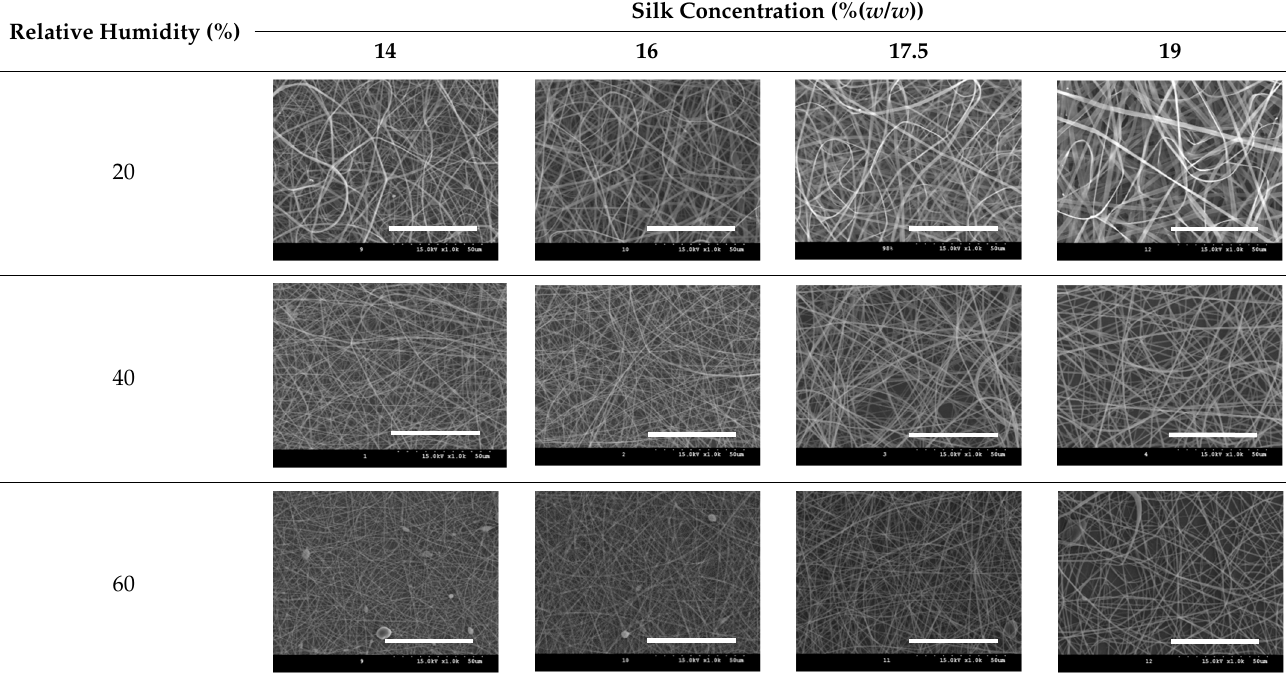
Table 1. Field emission-scanning electron microscopy photographs of electrospun silk fibers with various silk concentrations and relative humidities. The white magnification bars in the image represent 50 µ m. Relative Humidity (%)